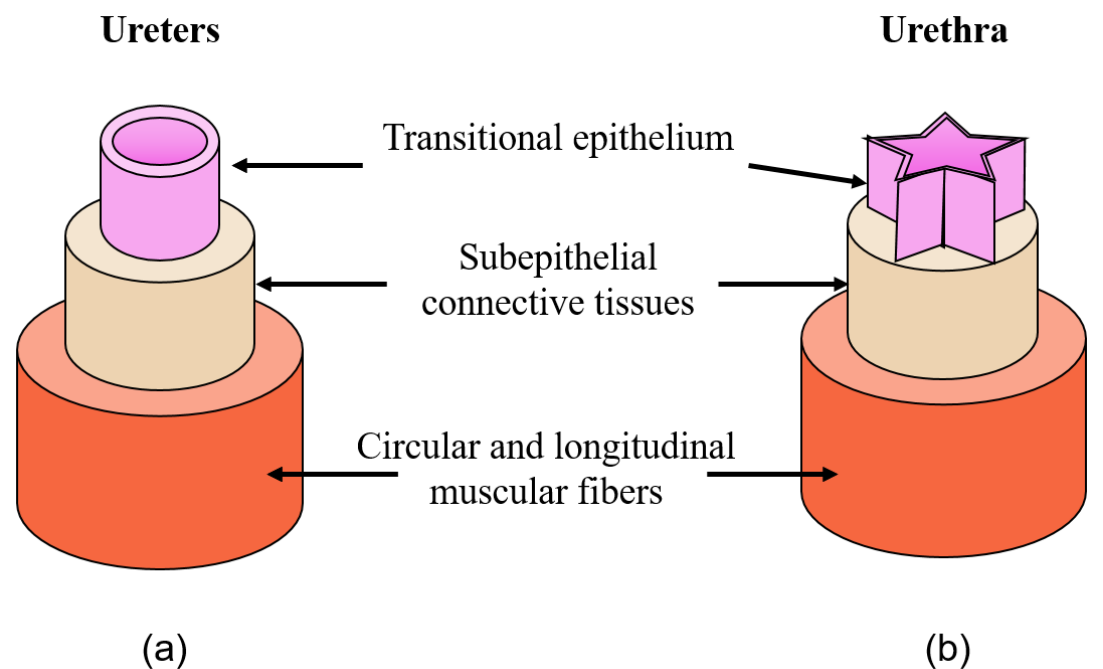
Figure 4. Schematized anatomy of urological conduits. ( a ): schema of the ureters’ anatomy; ( b ): Schema of the anatomy of the urethra.